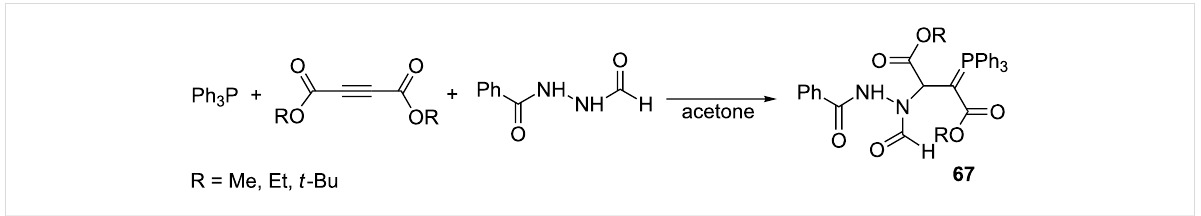
Scheme 44: Synthesis of resonance-stabilized phosphorus ylides via the reaction of triphenylphosphine with dialkyl acetylenedicarboxylates and N